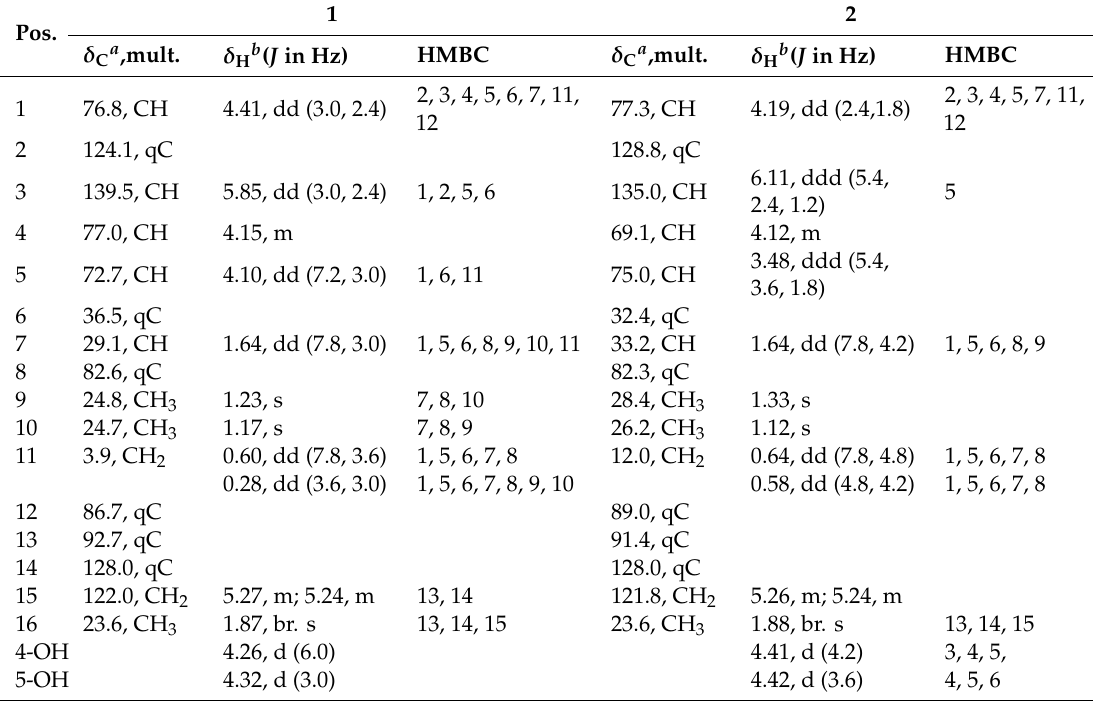
Table 1. NMR Data for 1 and